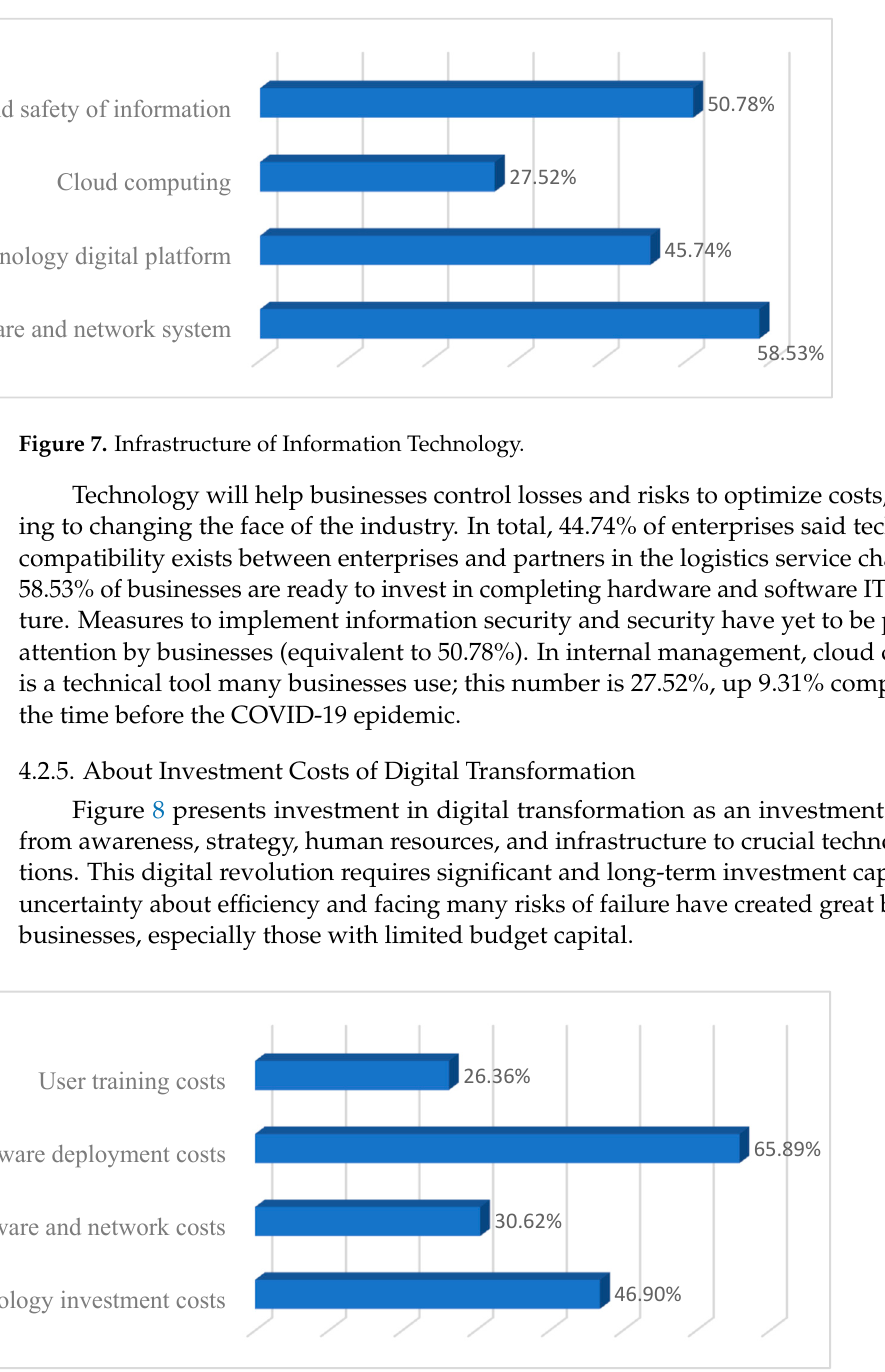
Figure 6. Human resources for digital transformation.